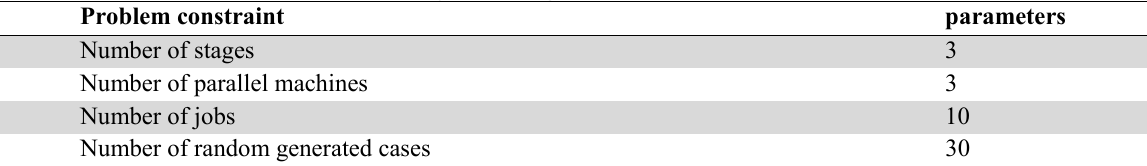
Problem constraint with machines and job setting